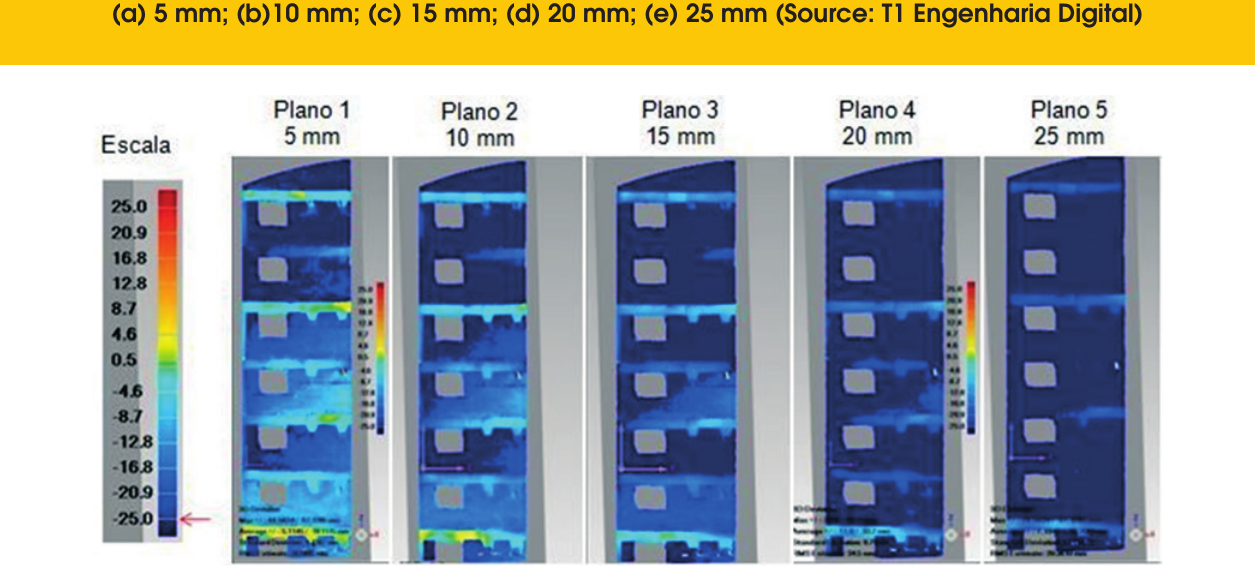
Figure 13 – Image of planes parallel to the 1st reference plane at a distance of: (a) 5 mm; (b)10 mm; (c) 15 mm; (d) 20 mm; (e) 25 mm (Source: T1 Engenharia